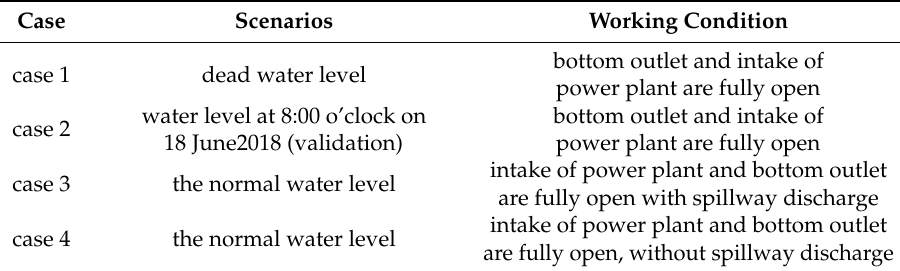
Table 3. Scenario analysis and corresponding working